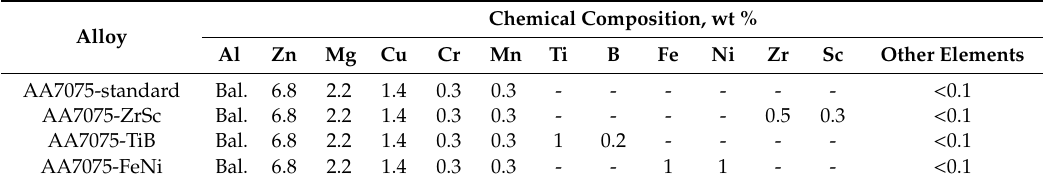
Table 1. Chemical compositions of the investigated alloys, in wt